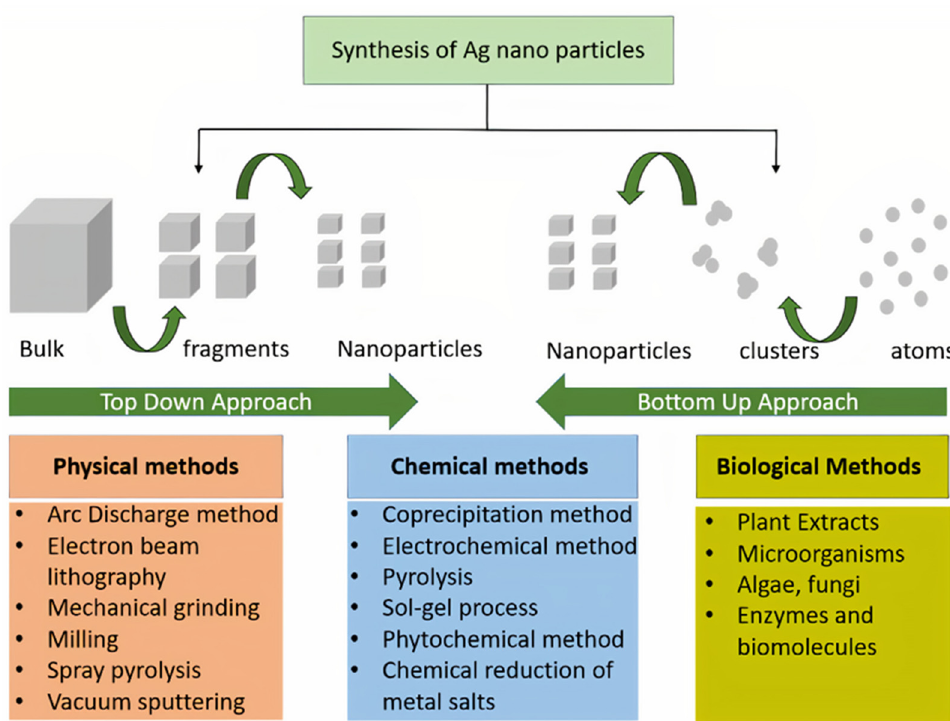
Figure 2. Different methods of synthesizing silver nanoparticles (AgNPs).